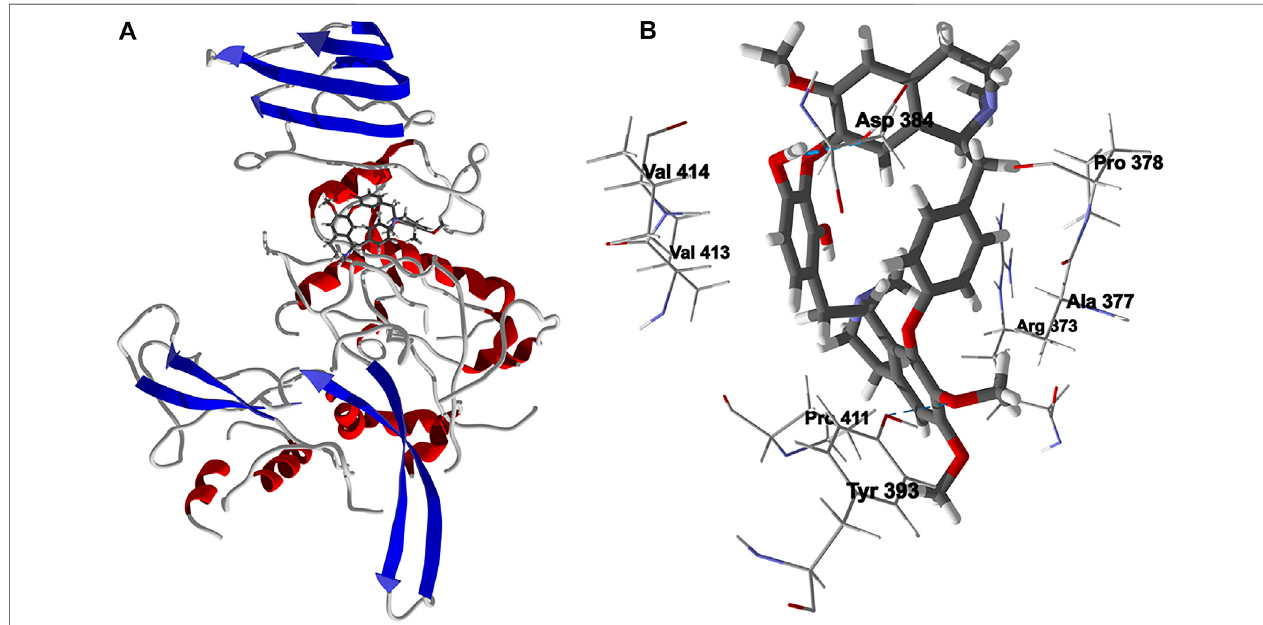
FIGURE 9 | Lowest-energy docked pose of chondrofolinol with Leishmania major uridine diphosphate-glucose pyrophosphorylase (Lmaj UGPase, PDB 2OEF). (A) : Ribbon structure (the docked chondrofolinol is shown as a stick fi gure). (B) : Active site showing the interactions of important contacts in the active site with the docked ligand (hydrogen-bonded interactions are indicated with blue dashed